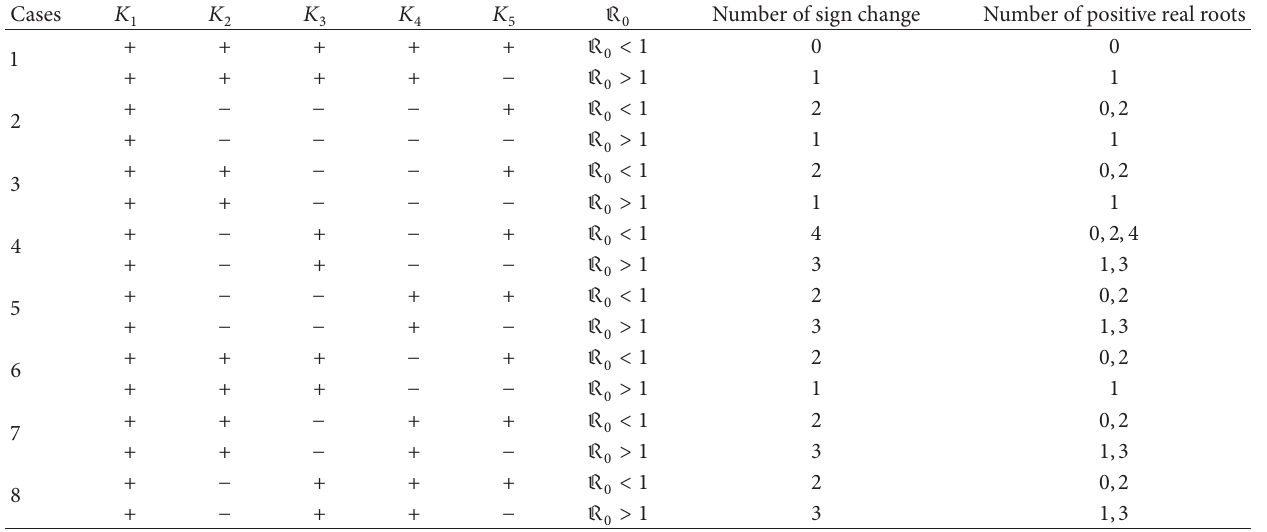
Table 1: Number of possible positive real roots of 𝑓(𝐼 ∗ ℎ ) for ℜ 0 > 1 and ℜ 0 < 1